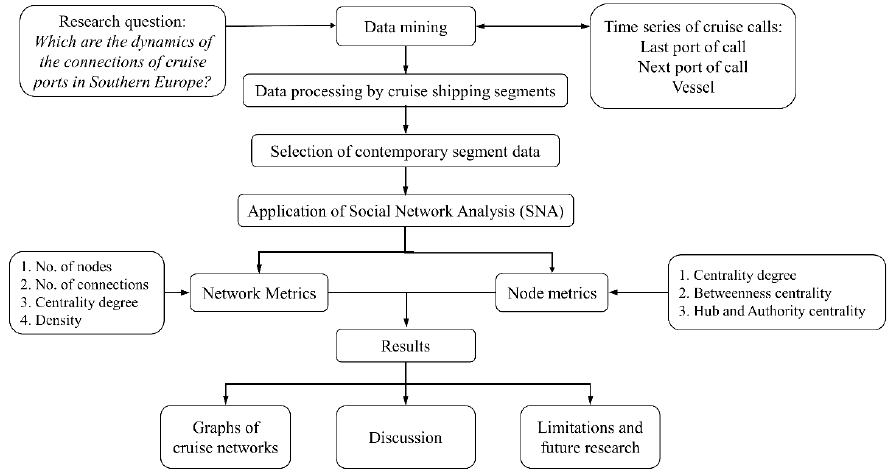
Figure 2. Diagram of the process carried out in the research. Source: Authors